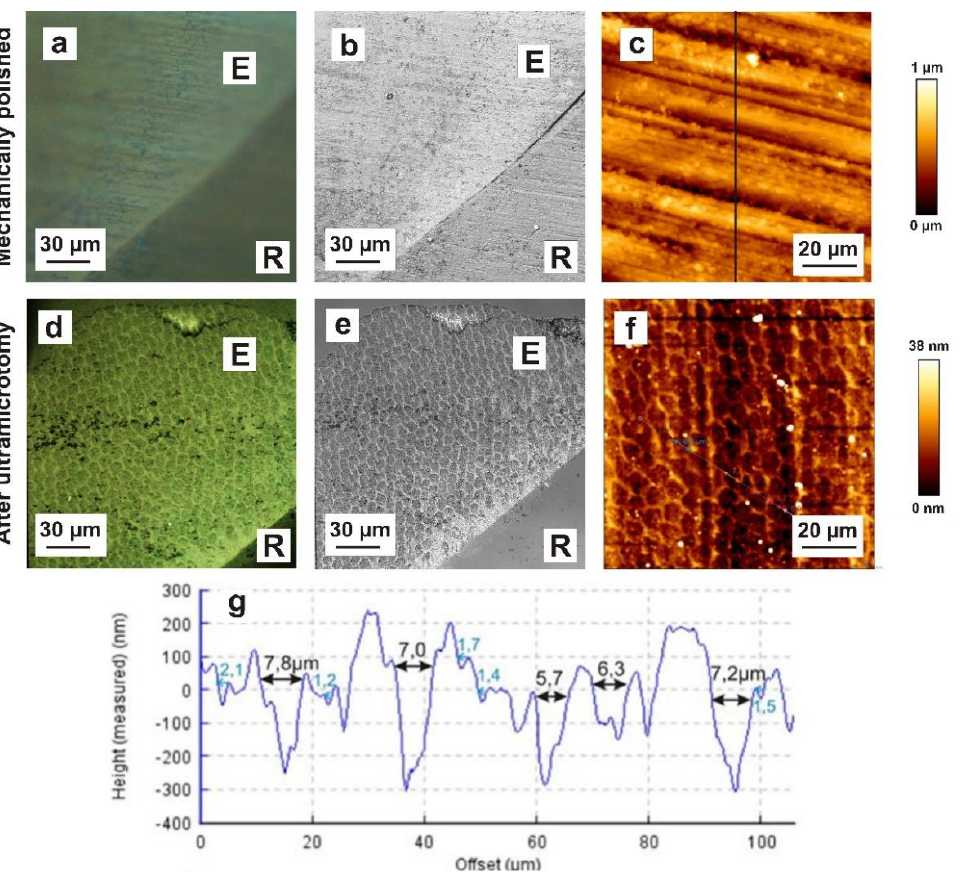
Figure 5. Comparison of enamel block surface morphology after mechanical polishing and ultrami- crotomy. ( a ) Reflected-light microscopy (differential interference contrast mode) of mechanically polished enamel showing polishing marks on the enamel surface with enamel (E) and resin (R). ( b ) Confocal laser scanning microscopy of mechanically polished enamel showing scratches and pol- ishing marks. The microstructure of enamel (prisms and interprismatic substance) is not obvious with enamel (E) and resin (R). ( c ) AFM micrograph of mechanically polished enamel depicting scratches and polishing marks. ( d ) Reflected-light microscopy of the enamel block surface after ul- tramicrotomy, showing the microstructure of enamel (prisms and interprismatic substance) with enamel (E) and resin (R). ( e ) Confocal laser scanning microscopy of the enamel surface after ultra- microtome preparation, depicting numerous prisms and the interprismatic substance with enamel (E) and resin (R). ( f ) AFM micrograph of the enamel surface after ultramicrotome preparation show- ing numerous prisms (dark red area) and the interprismatic substance (yellow area). ( g ) Horizontal height profile of the mechanically polished enamel surface measured by AFM, showing the surface roughness at the microscale in detail. ( h ) Horizontal height profile of the same enamel sample after ultramicrotome preparation, measured by AFM.